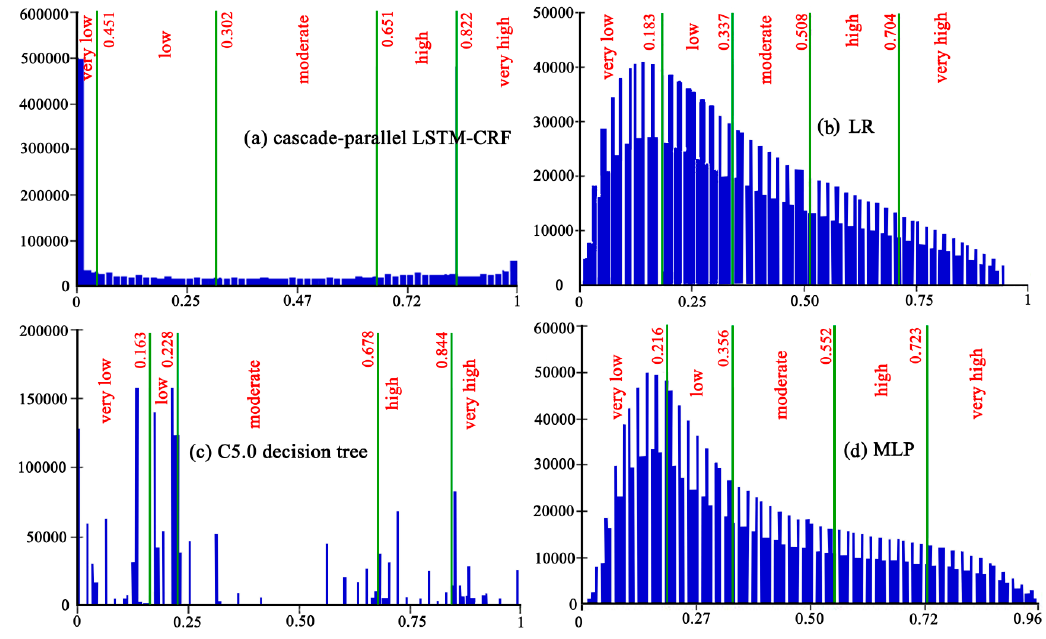
Figure 7. Landslide susceptibility index (LSI) distribution features of ( a ) LR, ( b ) MLP, ( c ) C5.0 decision tree, and ( d ) cascade-parallel LSTM-CRF.